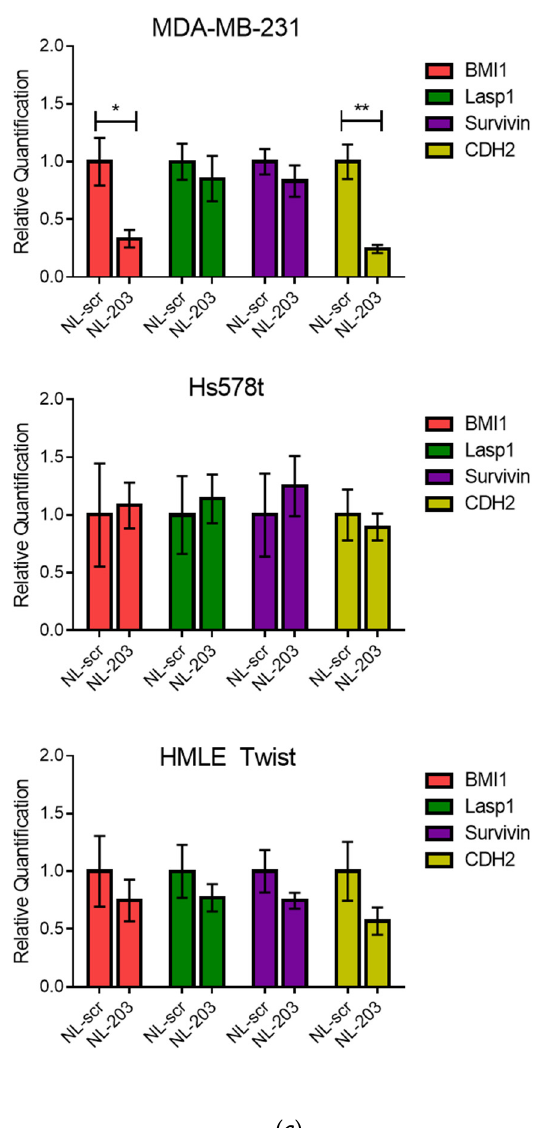
Figure 4. mRNA expression was measured by Nanostring PlexSet analysis and qRT-PCR. ( a ) Counts were normalized to three control genes and represented as z-scores within a hierarchical cluster. ( b , c ) Expression of indicated genes for cells with constitutive ( b ) or nanoliposomal-mediated ( c ) expression of miR-203 was determined using qRT-PCR. Mean and SEM of three biological replicates measured in technical quadruplicate are shown. Expression determined relative to vector or NL-scr control and normalized to GAPDH. p -value calculated using Student’s two-tailed t -test. * p < 0.05, ** p < 0.01 .